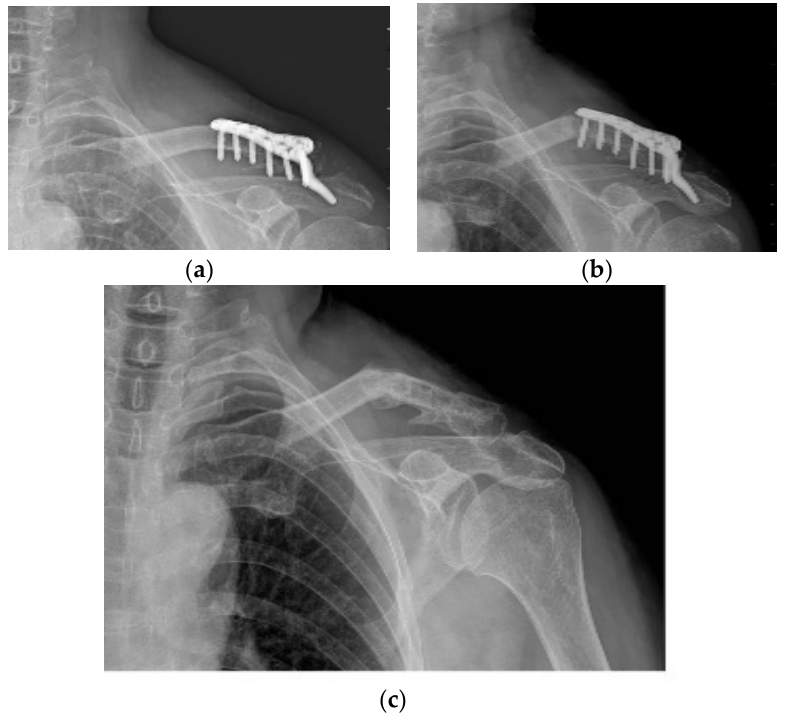
Figure 5. Peri-implant fracture. A 76-year-old female patient who underwent AO-type hook plating in the DCF group. ( a ) Postoperative clavicle anteroposterior radiograph view. ( b ) Patient showing peri-implant fracture on midshaft area of clavicle during the follow-up period of 4 months. ( c ) After removing the hook plate during the follow-up period, bone union is achieved.